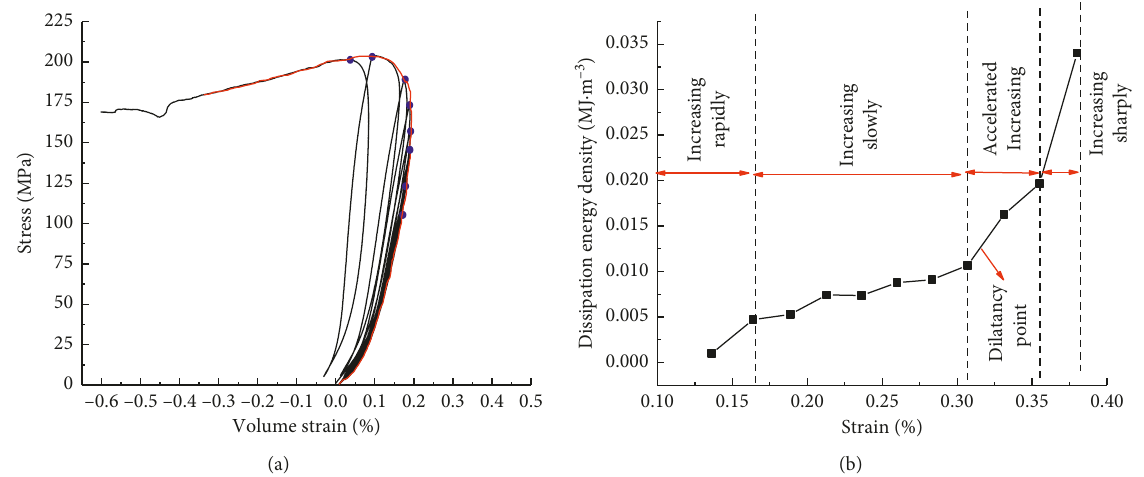
Figure 13: Variation in volumetric strain and dissipative energy under 1MPa confining pressure. (a) Outer envelope of volume strain. (b) Variation in dissipation energy with